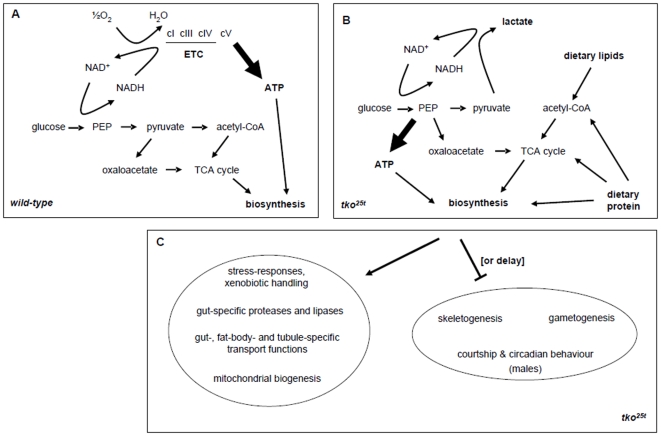
Summary of major alterations to gene expression and their proposed effects in tko25t flies.(a, b) Proposed metabolic effects, based on differences in gene expression affecting nutrition and metabolism between (a) wild-type and (b) tko25t flies. In wild-type flies glucose is metabolized via PEP to pyruvate, which is then fed to the TCA cycle mainly via the pyruvate dehydrogenase complex generating acetyl-CoA, with a small amount converted to oxaloacetate to replenish the TCA cycle intermediates as needed, maintaining a supply of carbon skeletons for biosynthesis. Surplus NADH is reoxidized via the ETC (complexes I, III and IV), generating potentially most of the cell's ATP needs at complex V. In tko25t flies, the maximal activity of the ETC complexes is only 10–20% that of wild-type flies [18]. For simplicity, its greatly decreased contribution to NADH oxidation and ATP generation is omitted altogether in panel (b). Instead, the bulk of ATP must be supplied by glycolysis, with NADH reoxidation dependent on lactate dehydrogenase and similar shunts. Because pyruvate is, under such conditions, mainly shunted to lactate, the TCA cycle must be supplied from other sources, via the mobilization of dietary lipids, generating acetyl-CoA, PEP carboxykinase (I) diverting a small amount of PEP to oxaloacetate, and the mobilization of dietary protein and amino acid catabolism supplying these and other TCA cycle intermediates, as well as biosynthetic reactions directly. The modifications to metabolism in tko25t flies are accompanied (c) by altered expression of genes connected with nutrient breakdown, absorption and transport, plus xenobiotic handling, affecting mainly the gut, Malpighian tubule and fat body. In addition, there is downregulation or delayed expression of genes connected with gametogenesis and skeletogenesis, and, notably in males, altered expression of genes controlling circadian and courtship behaviour, interpretable as a biological response to poor nutritional conditions.